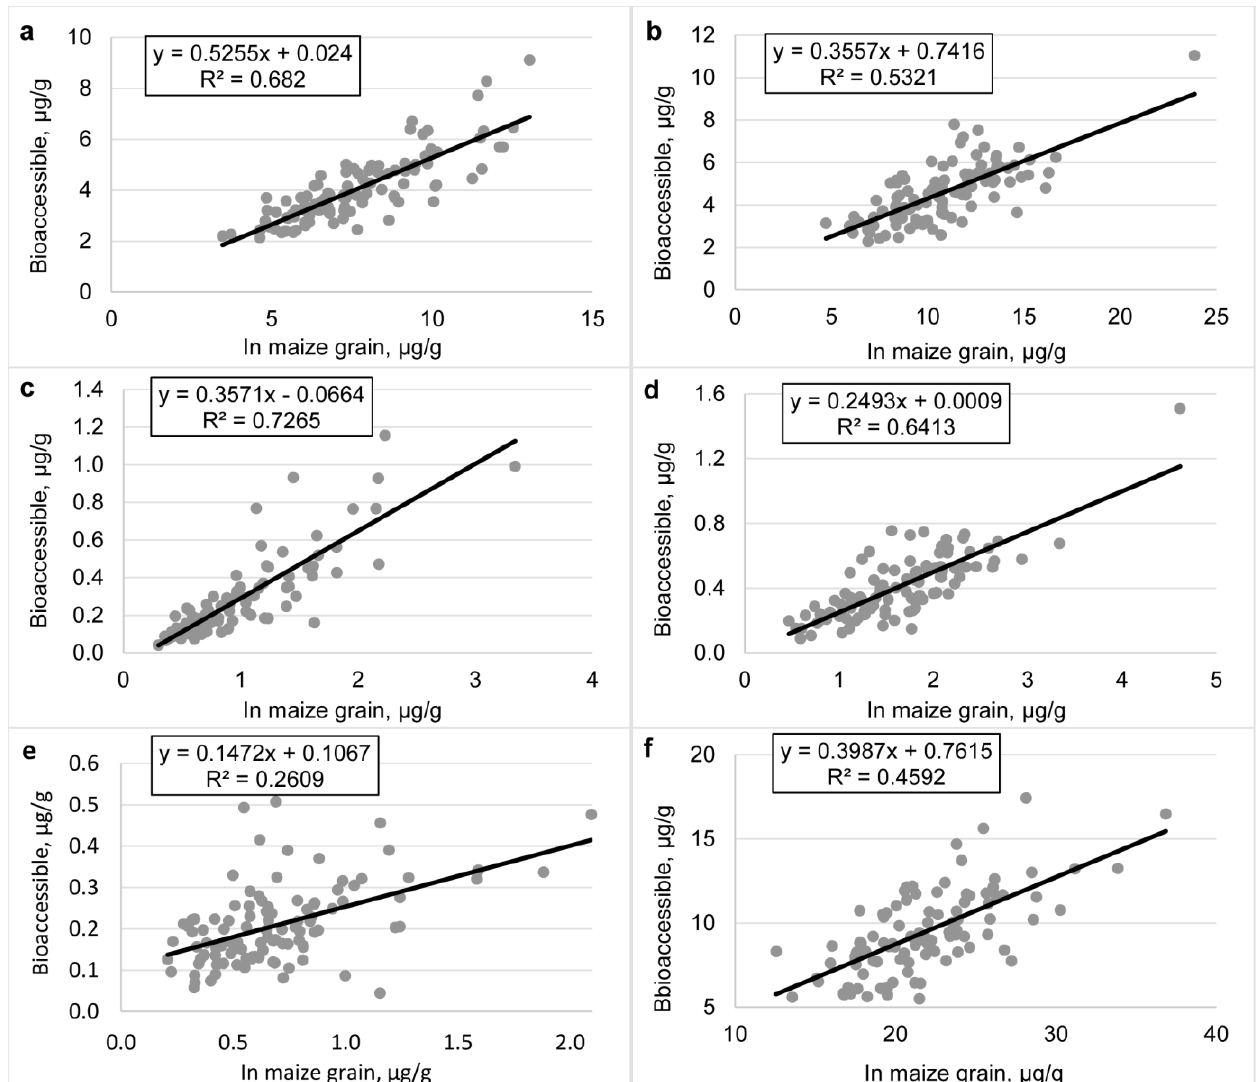
Figure 2. Linear regression of carotenoids, individual ( a ), lutein; ( b ), zeaxanthin; ( c ), α -cryptoxanthin; ( d ), β -cryptoxanthin; ( e ), β-carotene) and total ( f ), in whole maize grain and bioaccessible after INFOGEST in vitro digestibility analysis.